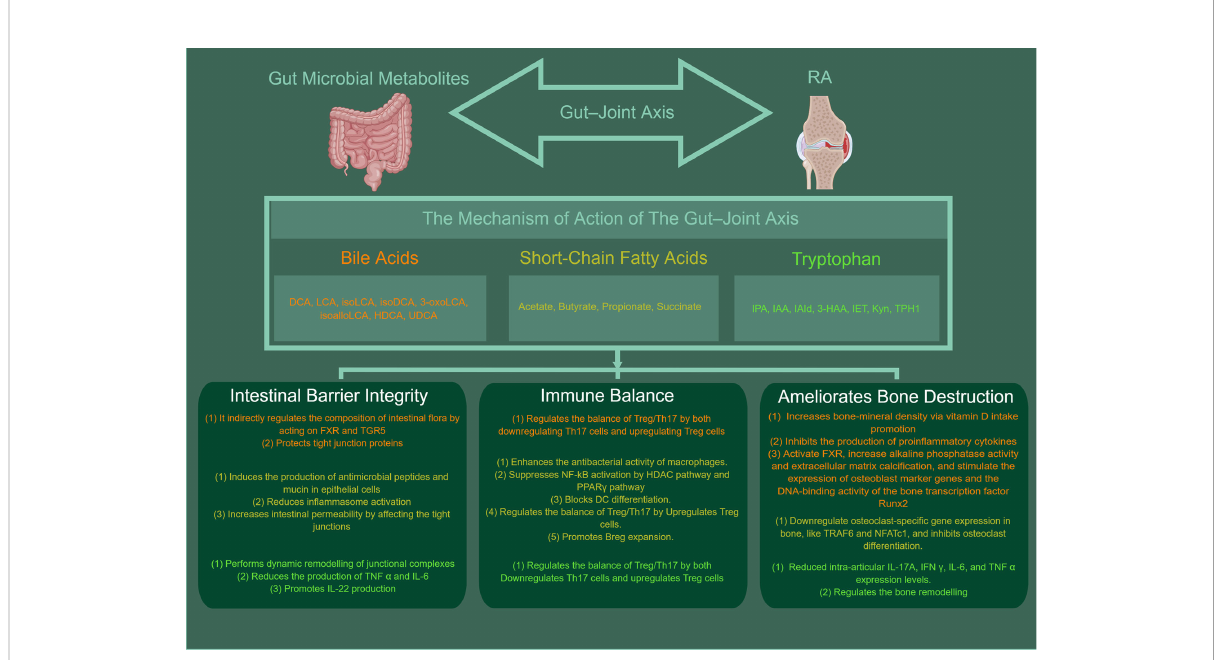
FIGURE 1 The mechanisms of gut microbial metabolites in RA. BAs, SCFA, TRP can protect the intestinal barrier by acting in a number of ways, such as directly via bactericidal effects or indirectly by acting on FXR and TGR5 to regulate the composition of the intestinal fl ora, modulate in fl ammatory factors (e.g., NF- k B, NLRP3, IL-6, IL-22), maintain the integrity of the apical linkage complex and its associated actin regulatory proteins and increase the levels of antimicrobial mucin peptides. In addition, it is apparent that intestinal microbial metabolites have a signi fi cant role in maintaining intestinal immune homeostasis. They can regulate the balance of Treg/Th17 or B cells, and enhances the antibacterial activity of macrophages. They can also suppresses NF- k B activation by HDAC pathway and PPAR g pathway and blocks DC differentiation. Meanwhile, the gut microbial metabolites can also be ameliorates bone destruction. The mechanism is related to increases bone-mineral density via vitamin D intake promotion, inhibits the production of proin fl ammatory cytokines, and ctivate FXR, increase alkaline phosphatase activity and extracellular matrix calci fi cation. And they can stimulate the expression of osteoblast marker genes and the DNA-binding activity of the bone transcription factor Runx2, downregulate osteoclast- speci fi c gene expression in bone, inhibits osteoclast differentiation. This picture was made by fi